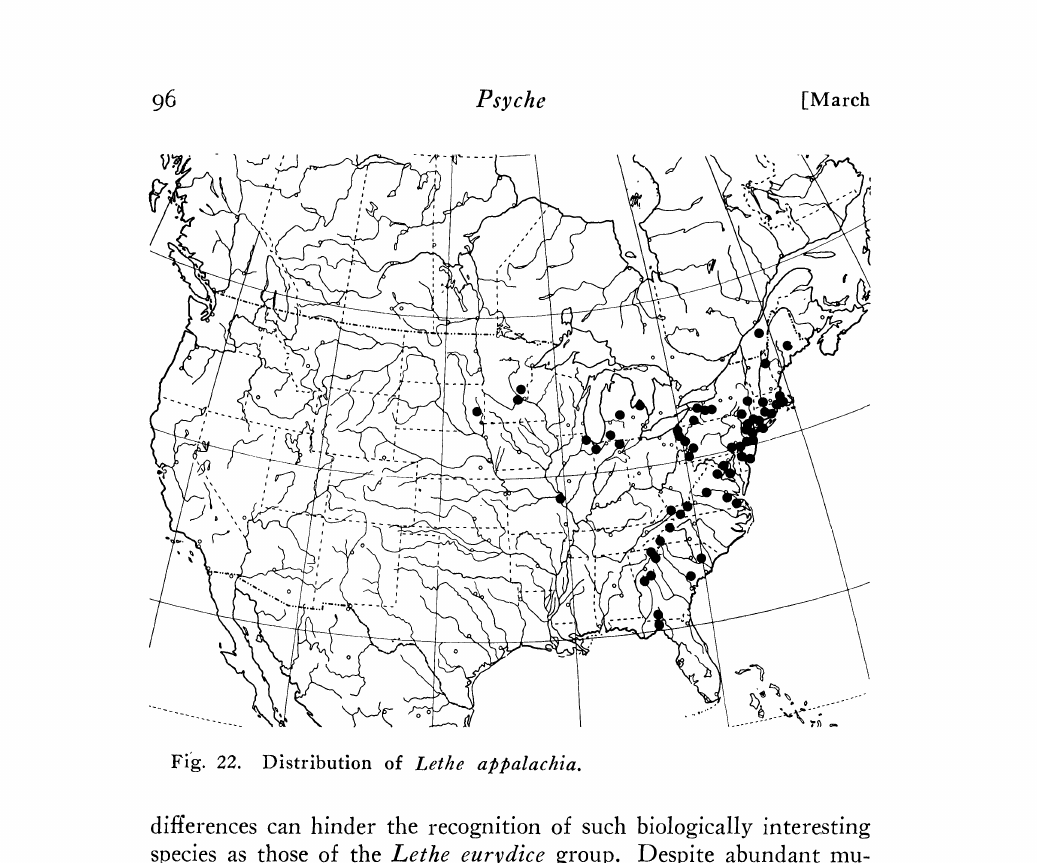
Fig. 22. Distribution of Lethe